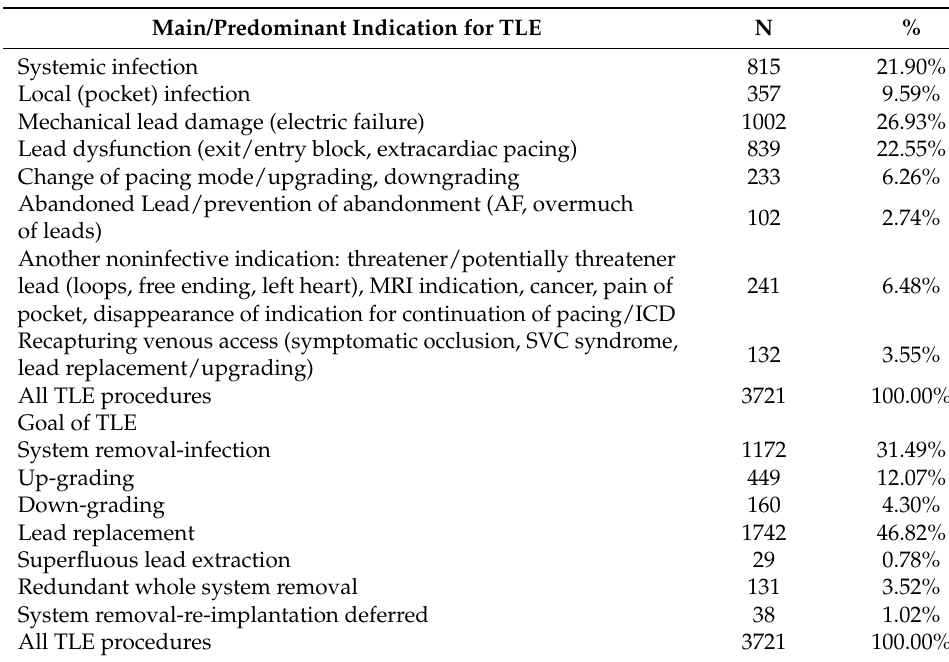
Table 1. TLE procedure indications, including goal and type of